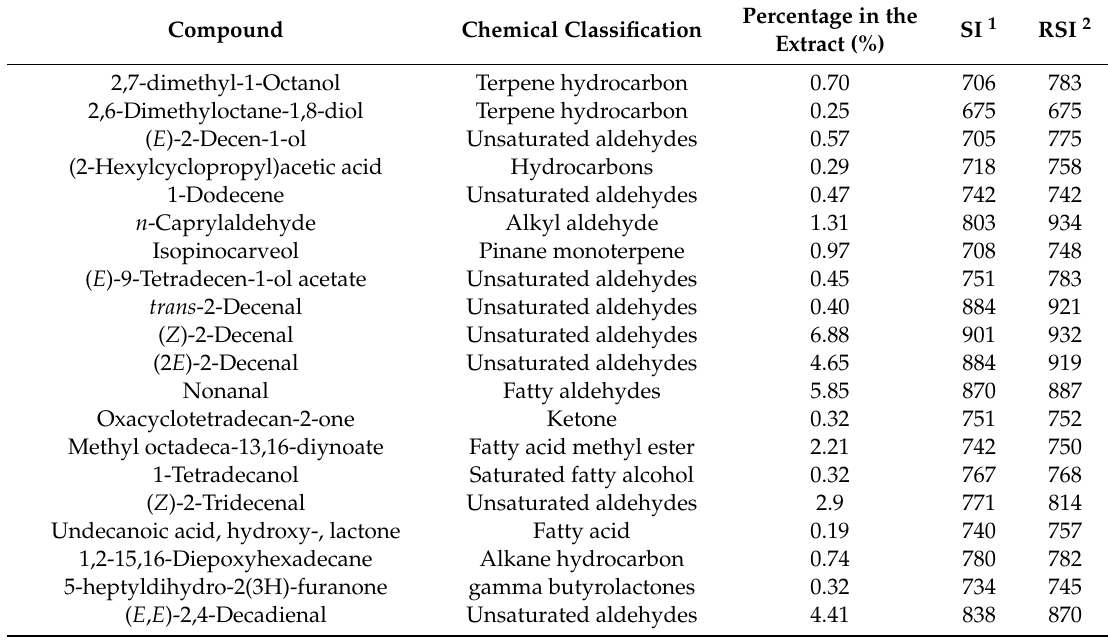
Table 3. Phytochemicals of oily liquid extract from P. halepensis branches by GC / MS.